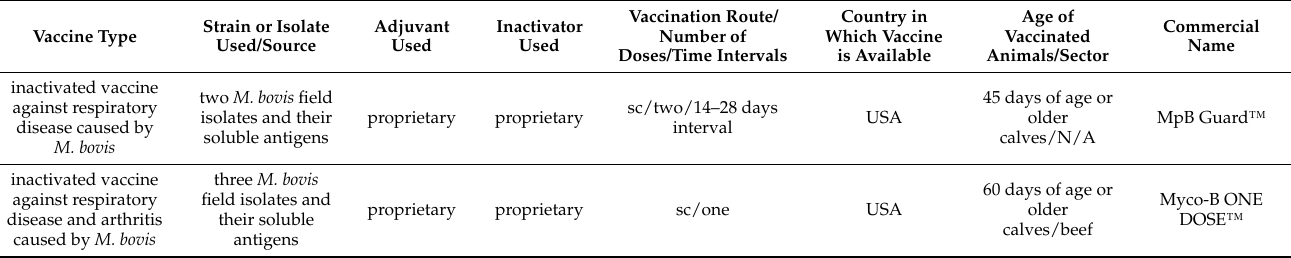
Table 2. Commercial vaccines against diseases caused by M. bovis